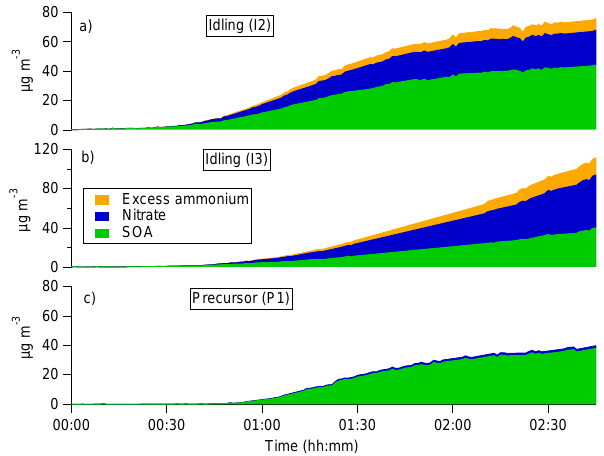
Fig. 4. Chemically resolved wall-loss-corrected mass concentration (µgm − 3 ) from AMS data from experiments I2 (a) , I3 (b) and P1 (c) . The ammonium sulfate seed has been subtracted. The reported ammonia is excess ammonia not bound to sulfate, thus indicative of ammonium nitrate formation. Time=00:00 indicates the start of the UV radiation. As an example for experiment I3, the non- wall-loss-corrected SOA concentration at the end of the experi- ment was 25µgm − 3 and the wall-loss-corrected concentration was 51µgm − 3 .